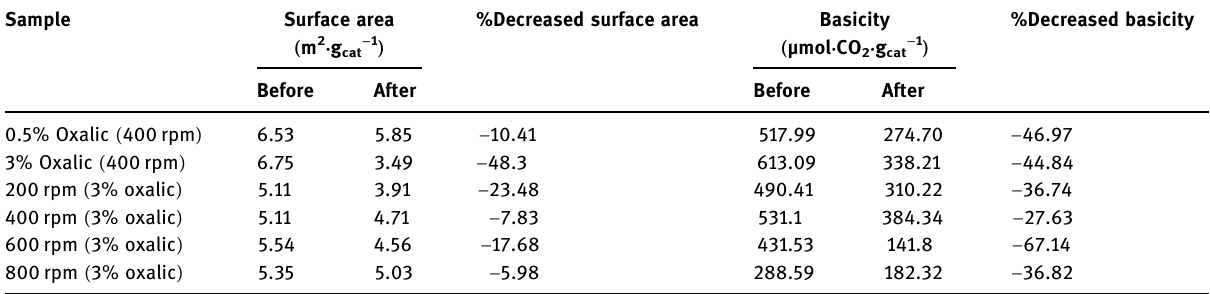
Table 3: Comparison of surface area and basicity of CeO 2 before and after transesteri fi cation reaction